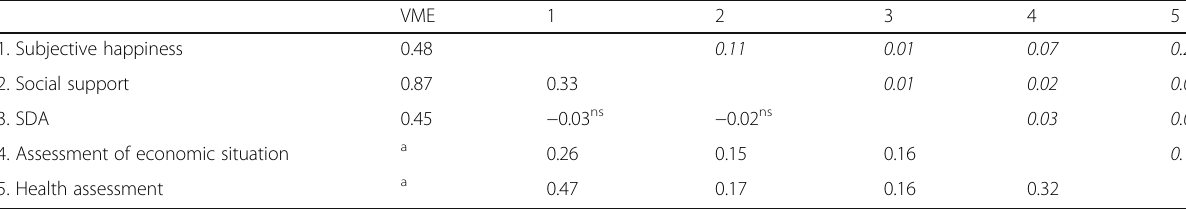
Table 1 Correlations between study variables and average variance extracted